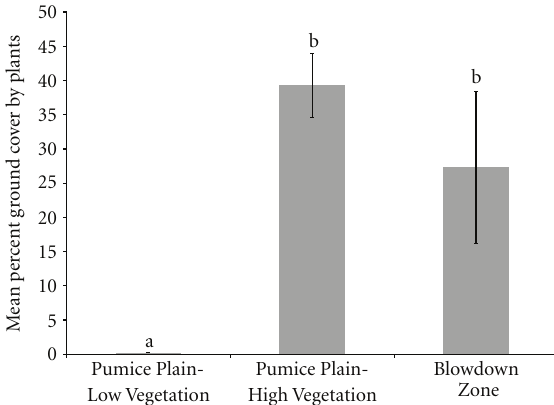
Figure 4: Shannon-Wiener Biodiversity Indices (mean biodiversity index ± 1 SE) for ant communities in three habitat types at Mount St. Helens National Volcanic Monument sampled between 22 and 25 July 2008. Di ff erent letters above the bars indicate significant di ff erences ( P < 0 . 05) between habitat types.